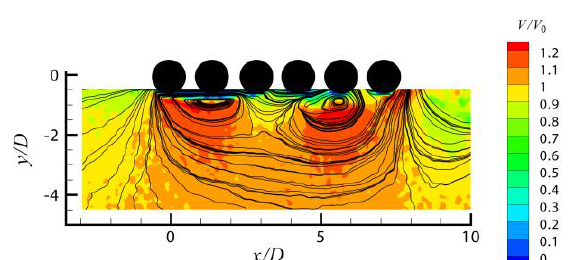
Fig. 9. Normalized velocity magnitude contours and third time step obtained for lateral region